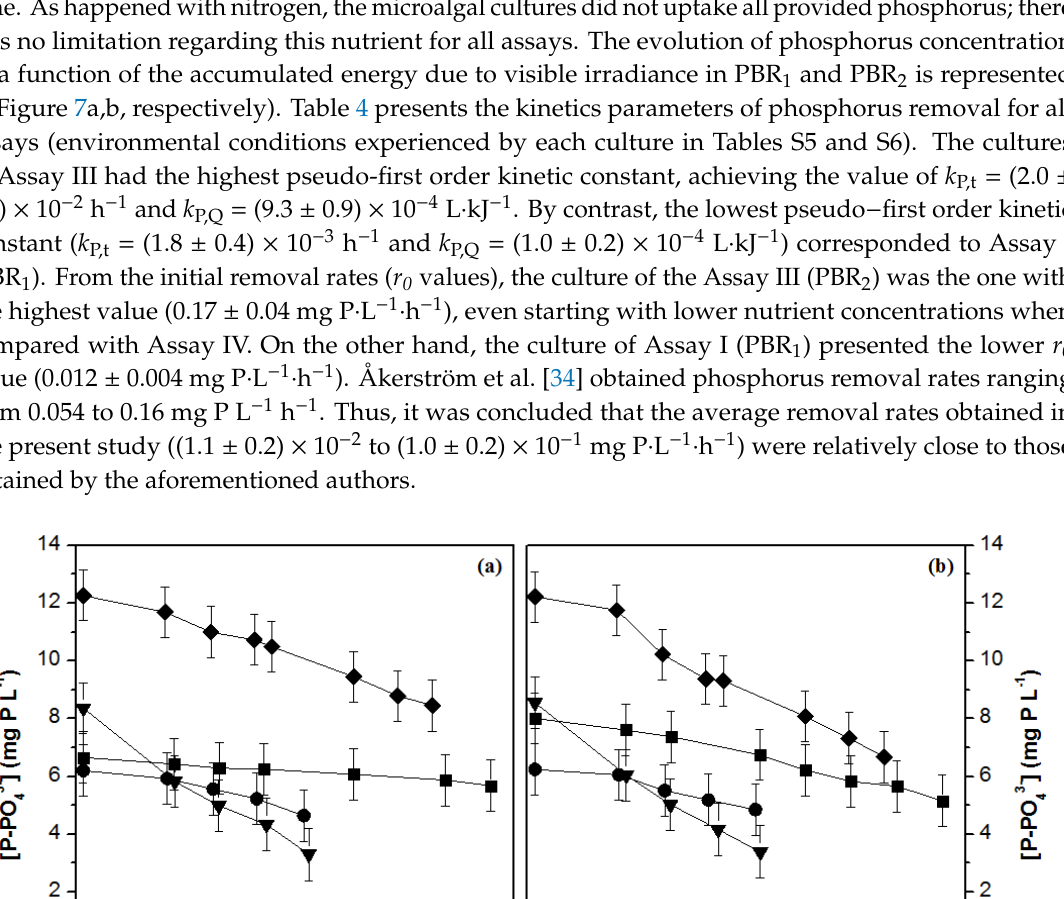
Figure 7. Variation of phosphorus concentration (P-PO 43− ) as a function of the accumulated visible energy ( Q VIS ) in PBR 1 ( a ) and PBR 2 ( b ) for all assays: I—  ; II—  ; III—  ; IV—  . Error bars correspond to the standard deviation of the mean determined for duplicates from two independent experiments.